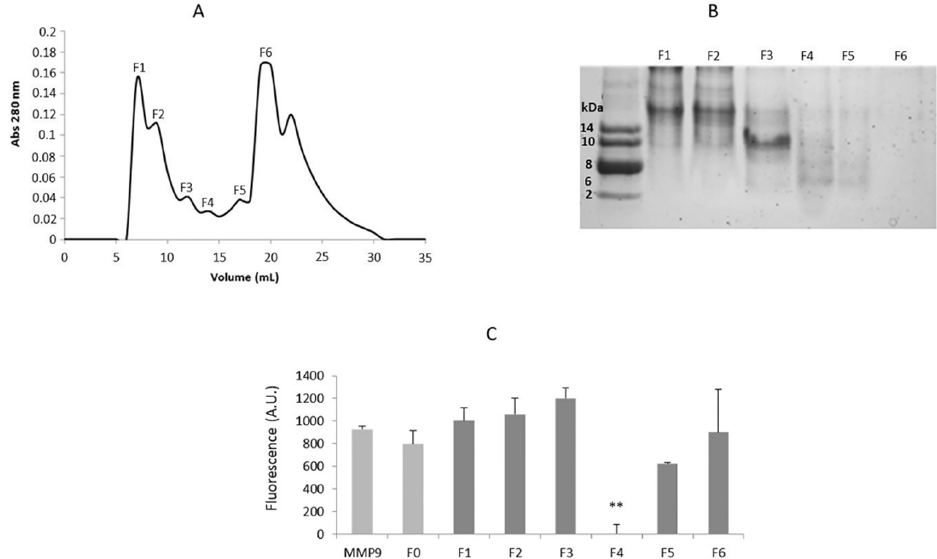
Figure 1. L. albus protein profile and corresponding MMP-9 inhibitory activity. ( A ) Size exclusion chromatography (SEC) in a Superdex 75 column of L. albus cotyledon total protein extracts. ( B ) Protein peaks were collected as fractions 1 to 6 and analyzed for polypeptide composition by SDS-PAGE. ( C ) MMP-9 proteolytic activity of fractions 1 to 6 obtained by SEC, as quantified by the DQ-gelatin method. Results are expressed in arbitrary units of fluorescence and represent an average of three replicates ± SD. ** p < 0.001 when compared to control.